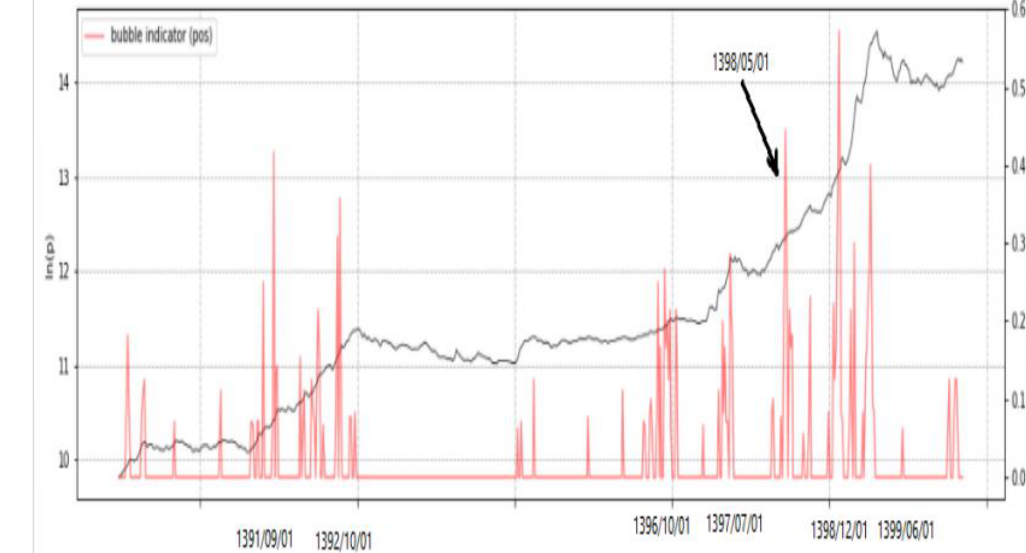
Figure 2, short term indicator of